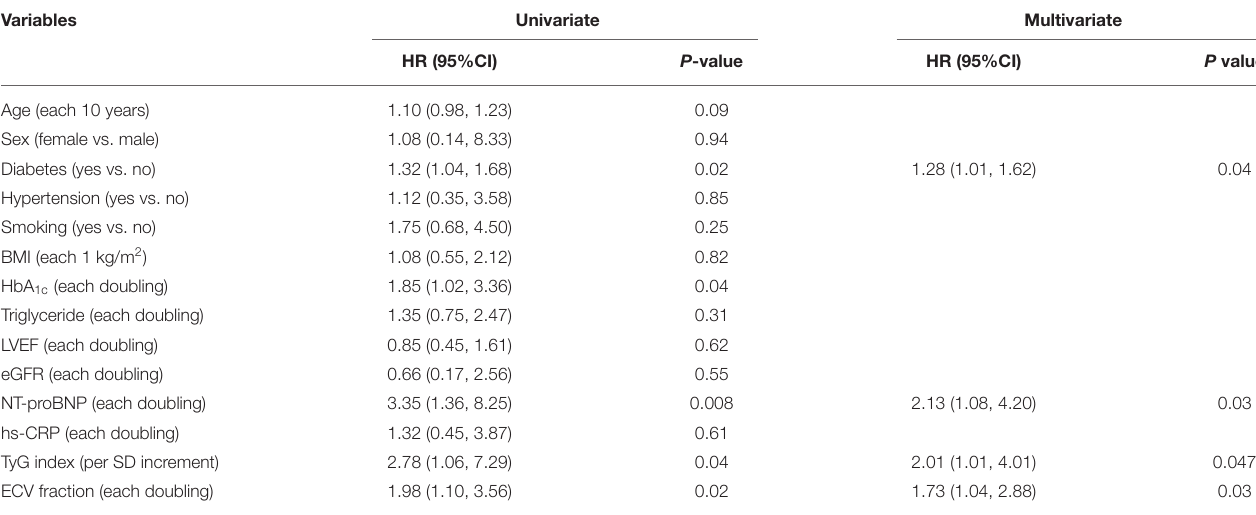
TABLE 3 | The association between risk factors and primary outcome in HF patients. Variables Univariate Multivariate